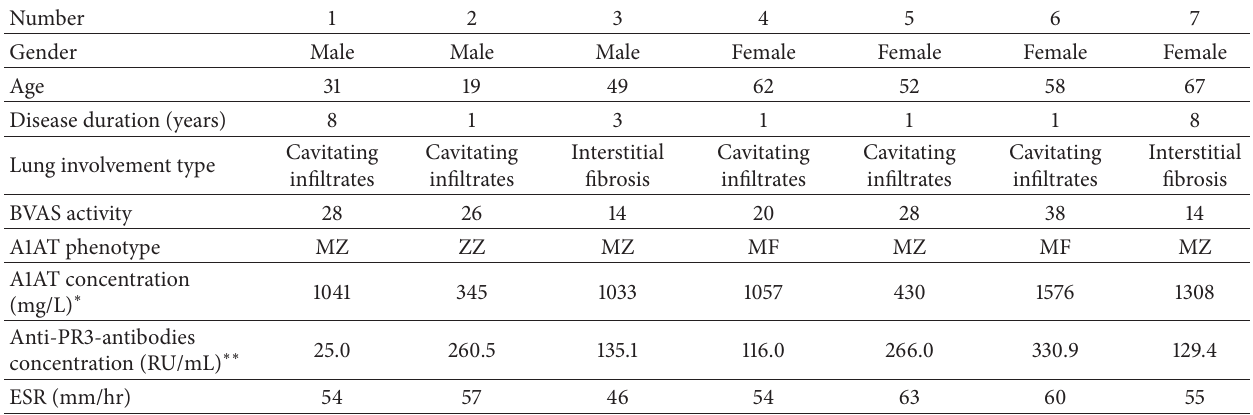
Table 1: The description of clinical data of GPA patients with pathological A1AT phenotypes.